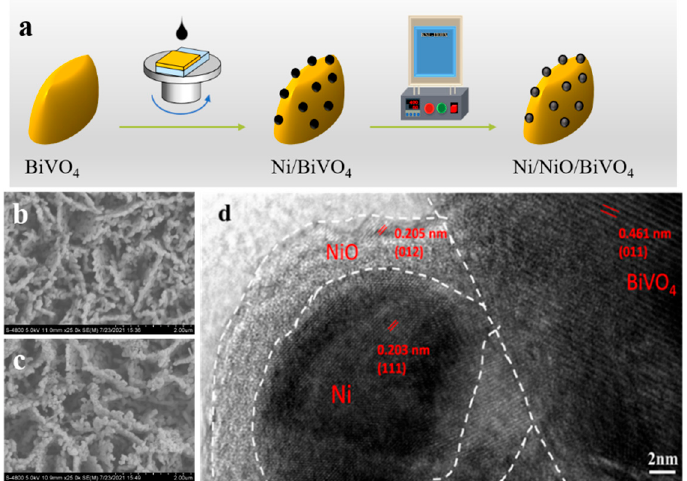
Figure 1. ( a ) The synthetic process of the heterostructure photoanode. SEM images of ( b ) bare BiVO 4 and ( c ) Ni@NiO/BiVO 4. ; ( d ) a HRTEM image of the Ni@NiO/BiVO 4 photoanode.